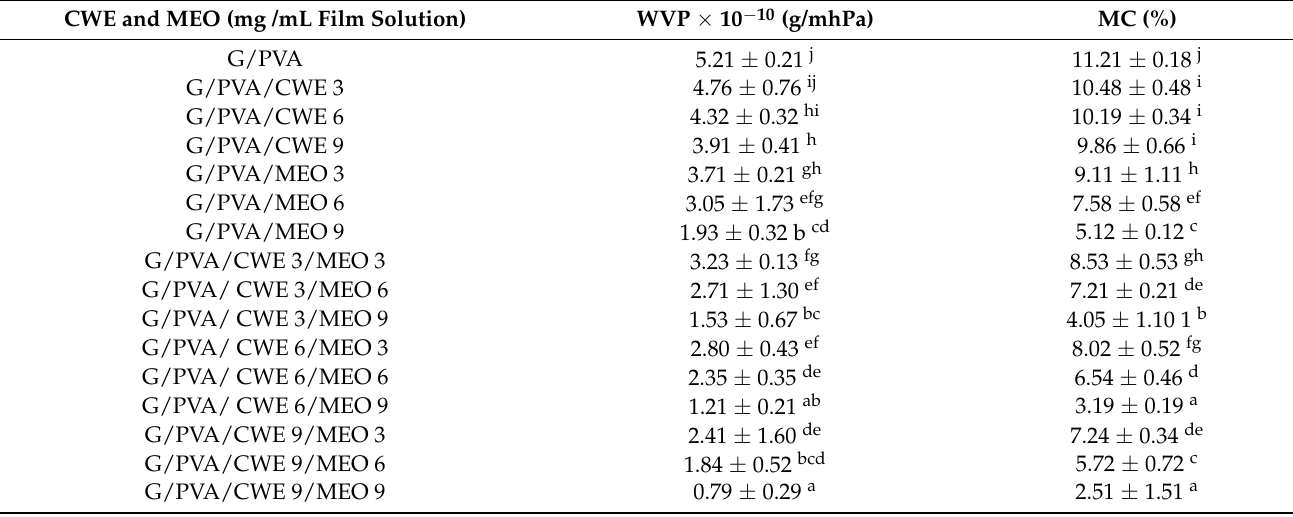
Table 3. Water vapor permeation and moisture content of the active